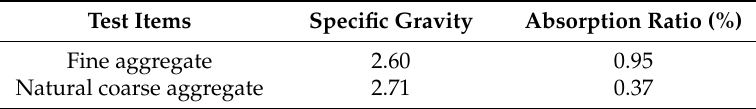
Figure 2. Aggregate gradation: ( a ) fine aggregate and ( b ) coarse aggregates. Table 2. Material properties of natural